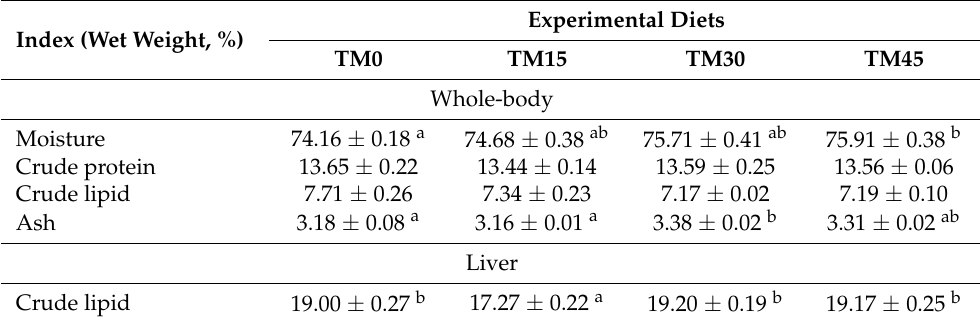
Table 4. Body compositions of large yellow croakers fed diets with different levels of TM.